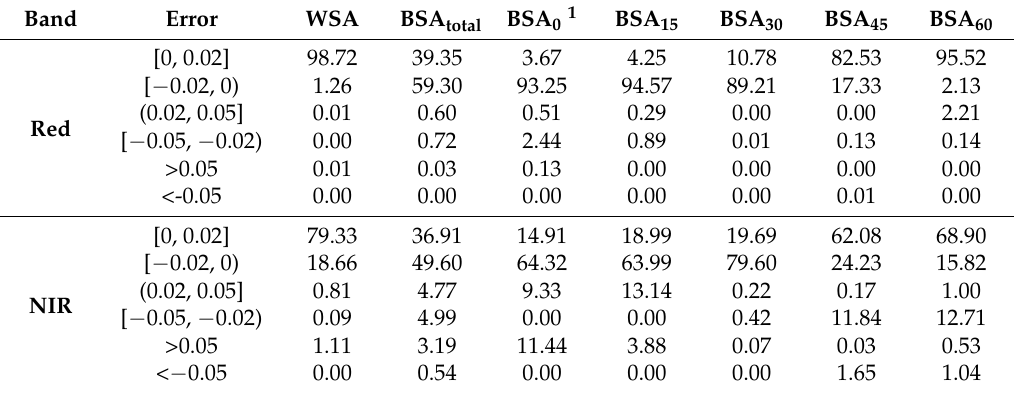
Table 4. The albedo deviation percentages between RTCLSR inversion and PROSAIL simulations in different accuracy ranges